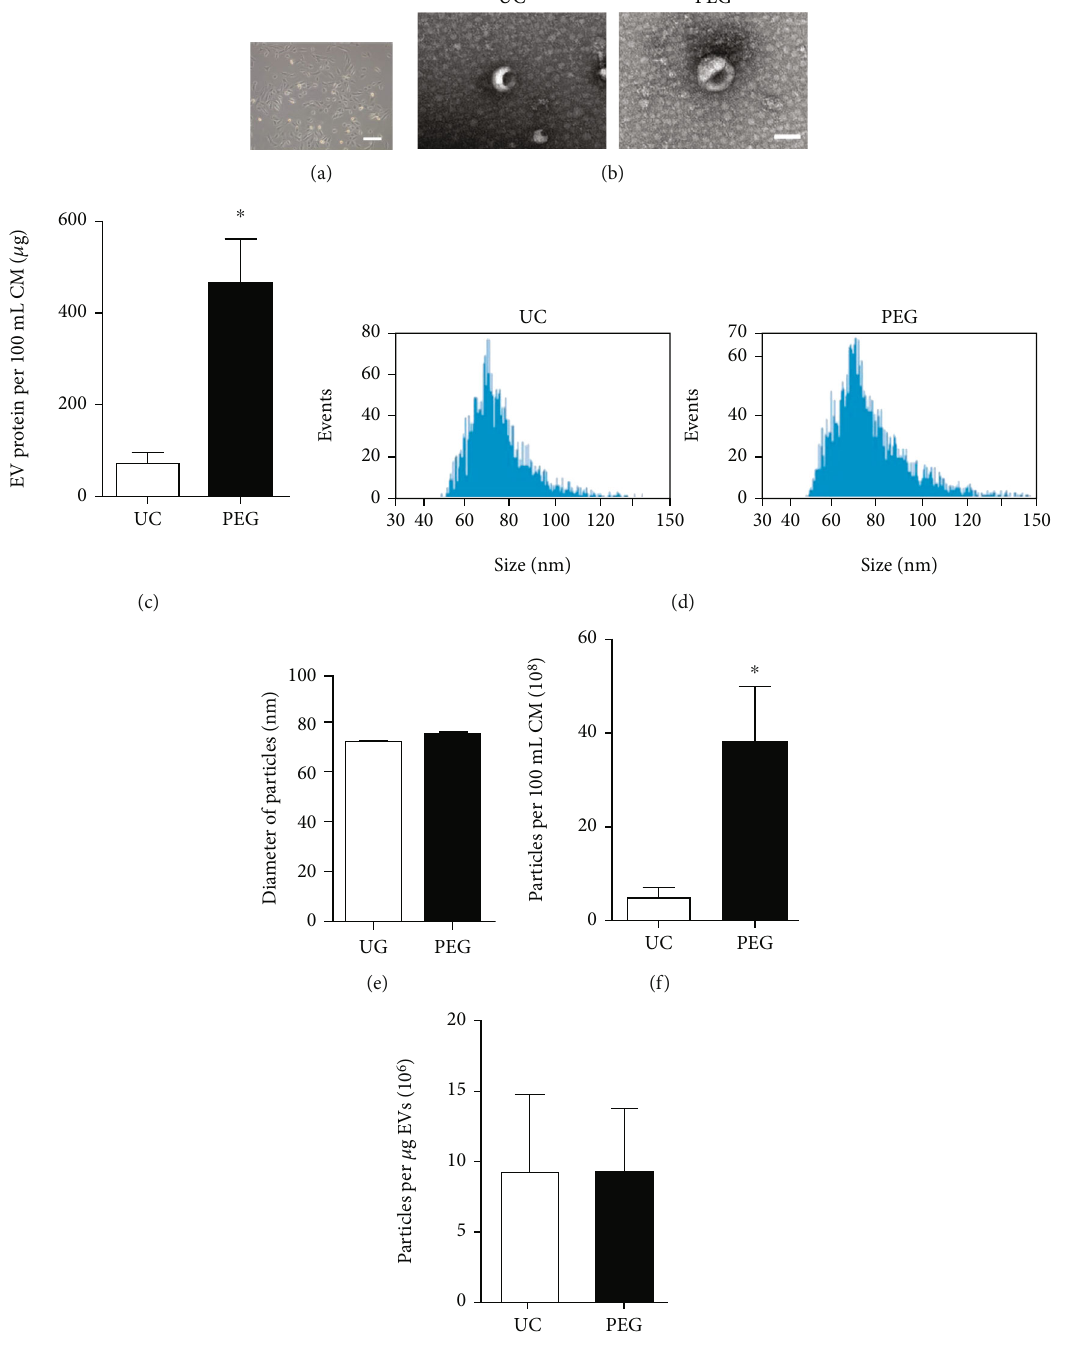
Figure 1: (a) Comparison of the quantity of EVs harvested by UC or PEG. (b) AF-MSCs, which are sources of EV production; scalebar = 100 μ m . EVs derived by UC and PEG presented similar morphology by electron microscopy, scalebar = 100 nm . (c) The proteins of EVs were quanti fi ed by BCA, and more proteins were derived by PEG than by UC ( n = 6 , ∗ for P < 0 : 05 ). (d) The distribution of EV sizes derived by UC or PEG. (e) There was no di ff erence in the diameter of the particles ( n = 3 ), (f) while signi fi cantly more particles were harvested by PEG than by UC ( n = 3 , ∗ for P < 0 : 05 ), (g) and there was no di ff erence in particles per μ g protein between UC-EVs and